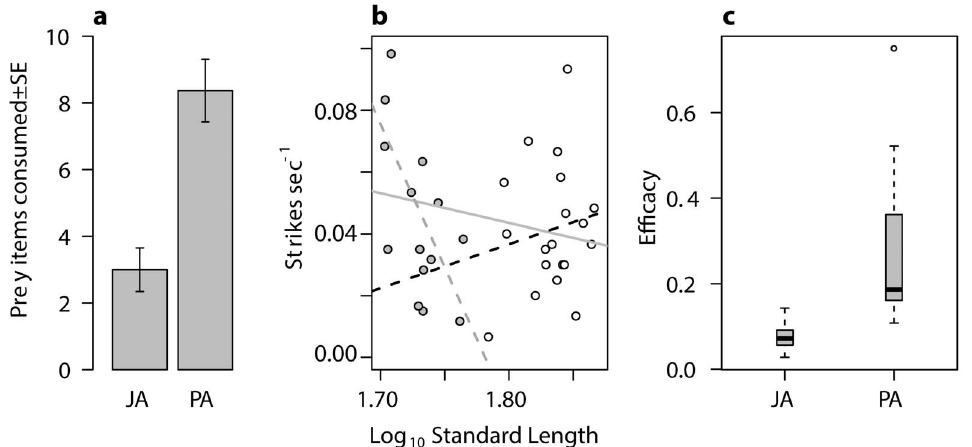
Figure 3. Measures of foraging efficiency for Japan Sea (JA) and Pacific Ocean (PA) anadromous stickleback; a) barplot showing mean values of chironomid larvae consumed; b) relationships between strike sec 2 1 and standard length, open and grey circles indicate PA and JA fish respectively, thick grey line represents common slope (R 2 5 0.01, F 1, 32 5 1.59 P 5 0.21), dashed black and grey lines indicate JA (R 2 5 0.31,